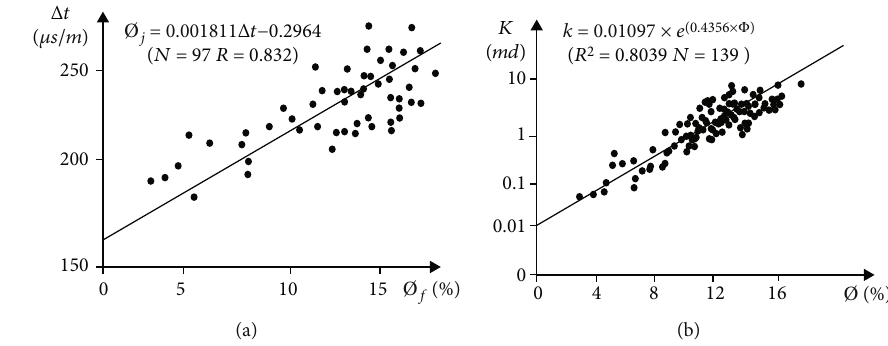
2 layer in the study area.